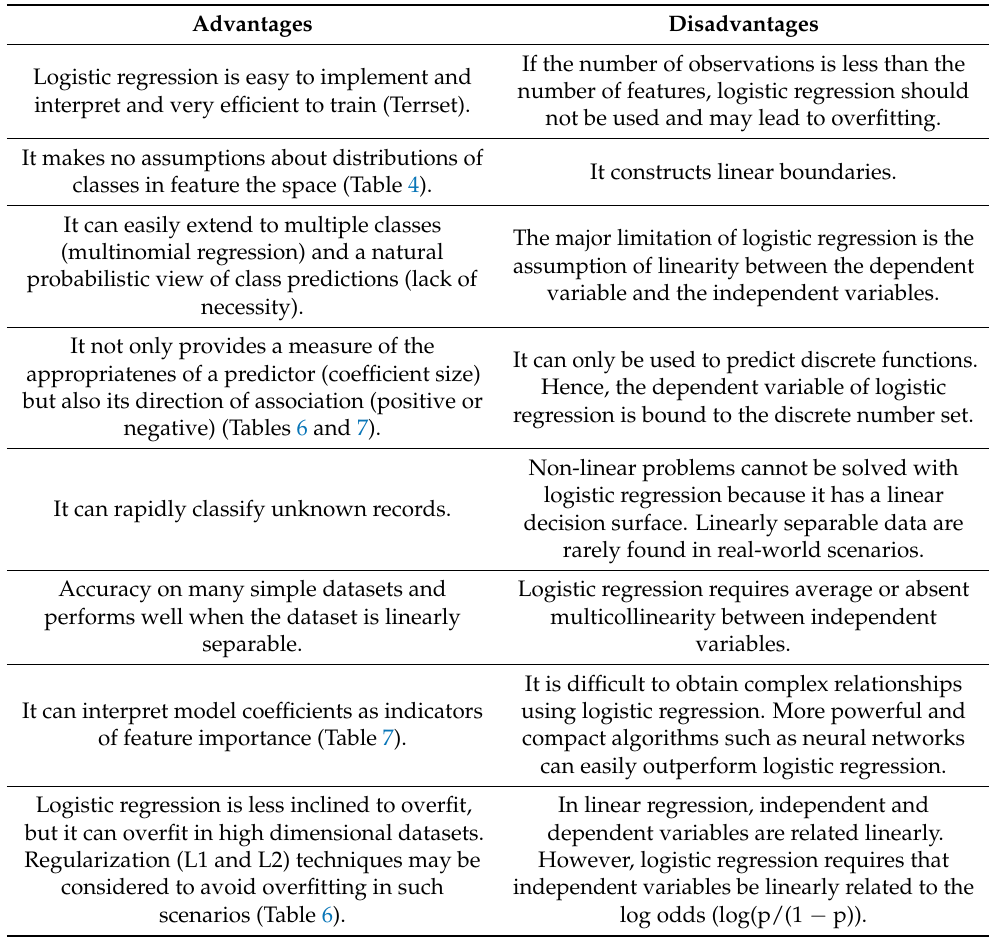
Figure 9. Urban growth probability maps of the TMA during three periods based on LTM data. Visual interpretation by overlaying of the probability map extracted by artificial Neural network Table 8. Model validation results in ANN based on the LTM model. and logistic regression methods shows the agreement of the two maps on the changed areas for the years 1984–2018. Based on the analysis of the probability of urbanization, the advantages and disadvantages of the ANN-LTM and LR were identified as follows (Tables 9 and 10): Table 9. Logistic regression advantages and